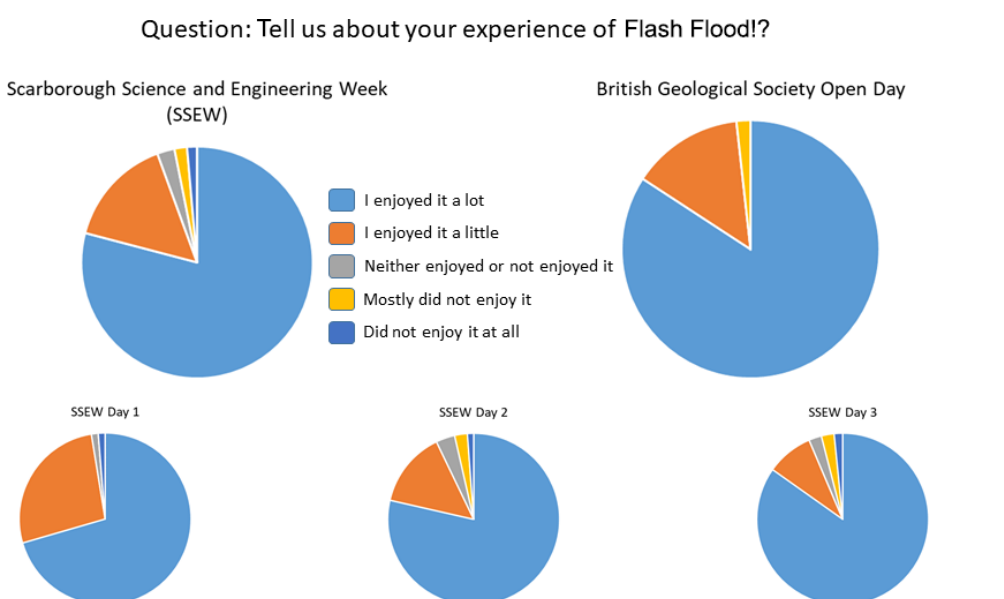
Figure 7. Charts showing the questionnaire responses to the question “Tell us about your experience of Flash Flood!?” from Scarborough Science and Engineering Week (8–10 October 2019) and the British Geological Survey Open Day (12 October 2019).